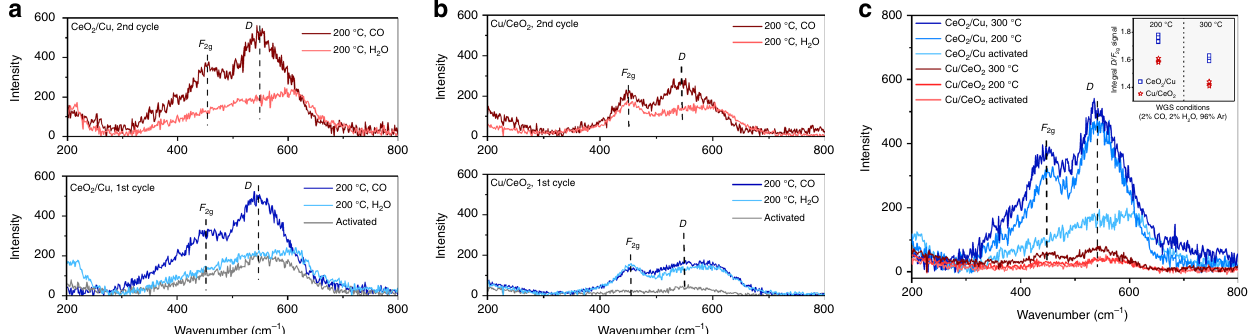
Fig. 5 Examination of defect sites in the catalysts. a In situ Raman spectra of the inverse CeO 2 /Cu with CO/H 2 O switch under 200 °C. b In situ Raman spectra of the normal Cu/CeO 2 with CO/H 2 O switch under 200 °C. c In situ Raman under the WGS conditions for both catalysts, the inset fi gure gave D / F 2g integral ratio at different